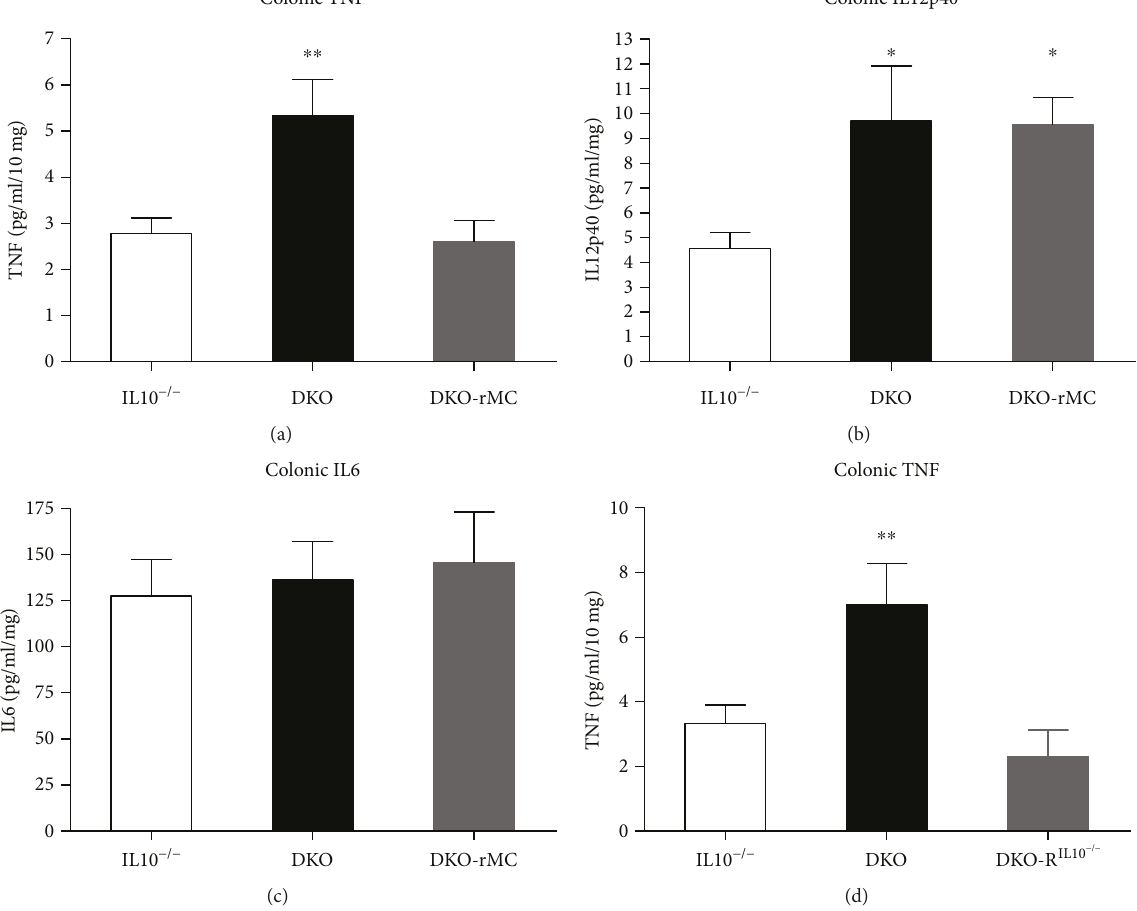
Figure 4: Spontaneous colonic cytokine production. (a) TNF is increased in DKO mice compared to IL10 − / − and is restored to baseline in DKO mice that are reconstituted with BMMCs. (b) IL12p40 is increased in DKO mice compared to IL10 − / − but is una ff ected by BMMC reconstitution. (c) Colonic IL6 is similar between IL10 − / − , DKO, and DKO mice reconstituted with BMMCs. (d) TNF is also restored to baseline in DKO mice reconstituted with IL10 − / − BMMCs compared to DKO mice. IL10 − / − : n = 25 ; DKO: n = 25 ; DKO- rMC: n = 13 . ∗ p < 0 05 , ∗∗ p < 0 01